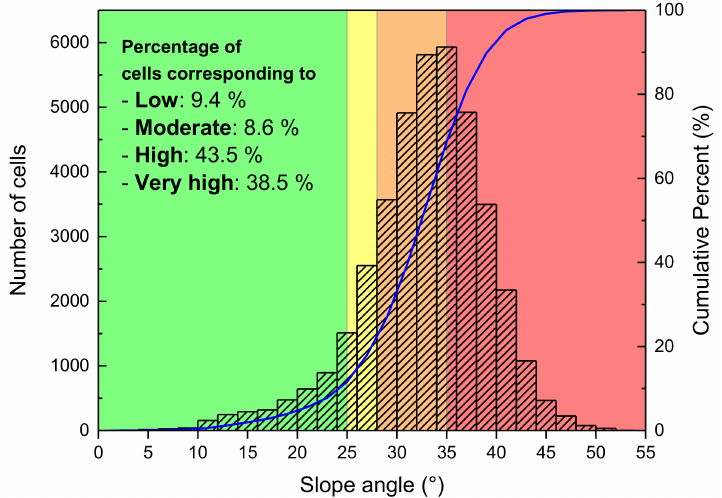
Figure 16. Slope angle distribution and landslide hazard levels of the analysis domain